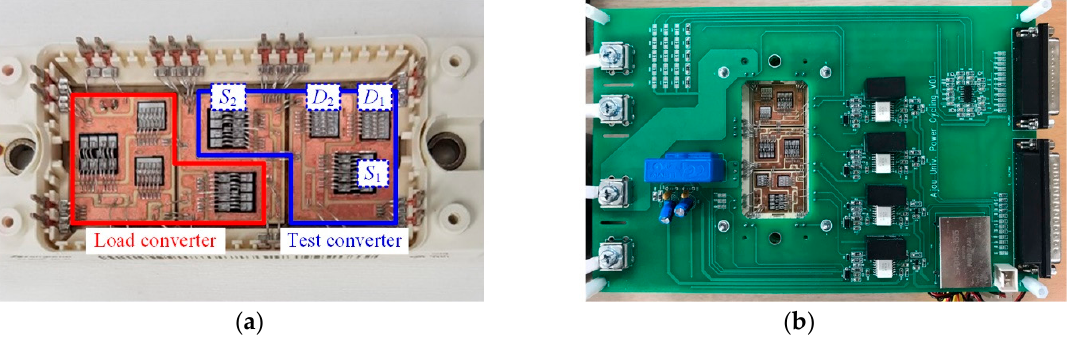
Figure 6. Decapsulated IGBT module (F4-50R12KS4): ( a ) F4-50R12KS4 with silicone gel removed; ( b ) power converter board with F4-50R12KS4 mounted.